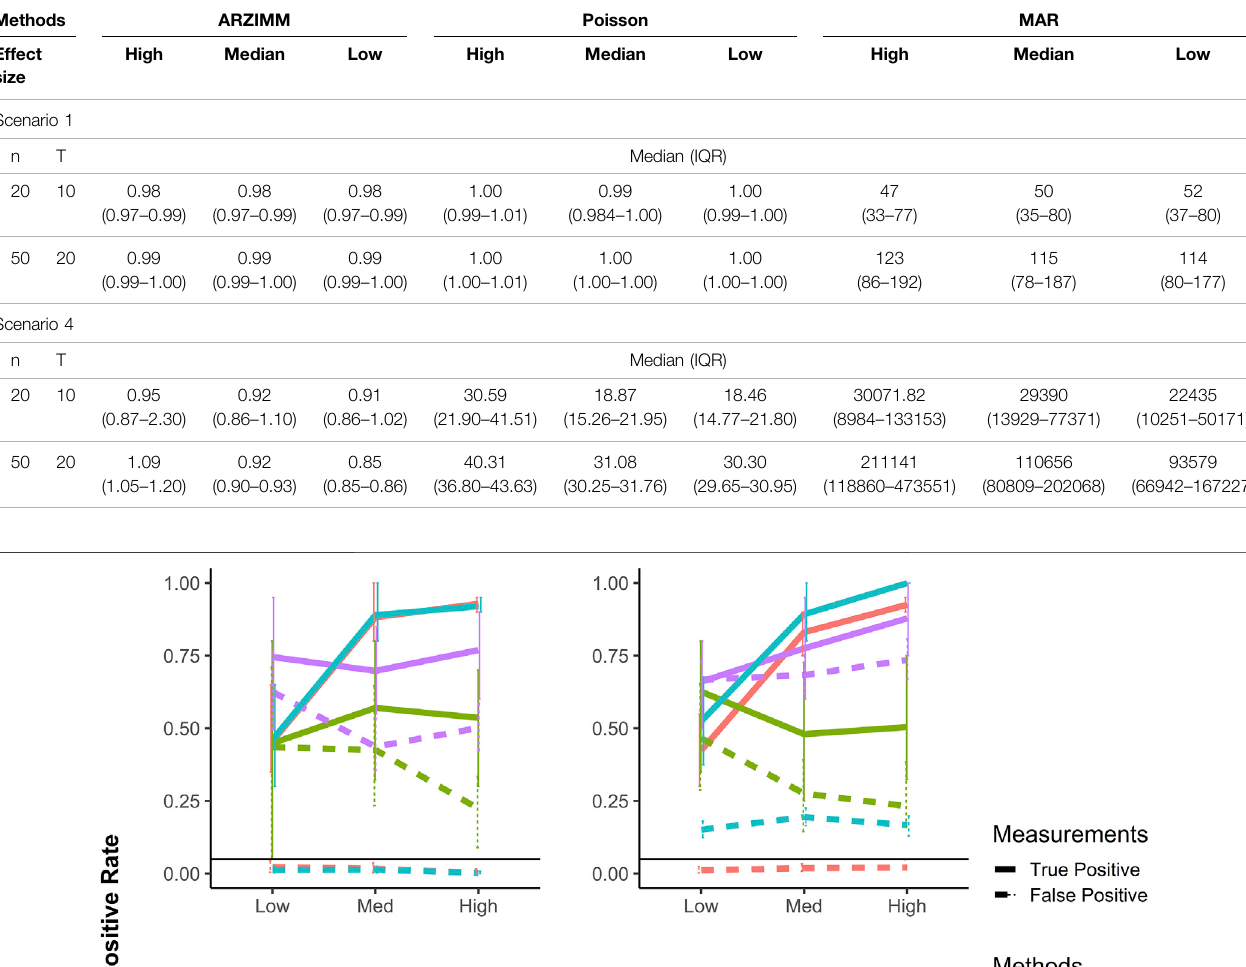
TABLE 1 | Simulation results for all settings under scenario 1 and 4. Poisson refers to the penalized Poisson autoregression model and MAR refers to penalized log-normal multivariateautoregressionmodel.Thereportedvalueismedian(IQR)ofmeannormalizedsquarederrorscore(MNSES)calculatedover500simulationsforeachsetting. n refers to the number of subjects, and T refers to the number of time points. Scenarios 2 and 3 are deferred to Supplementary Material.